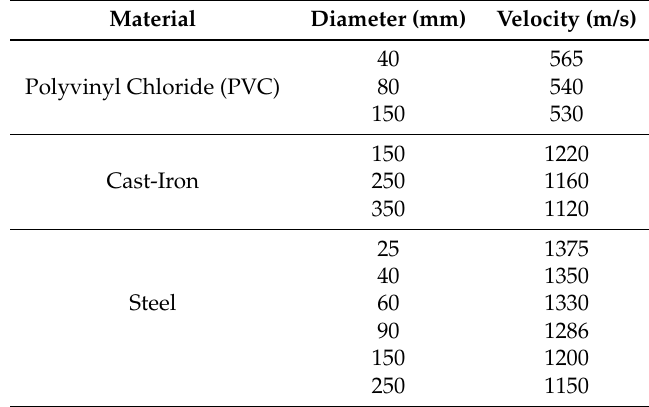
Table 1. Sound velocity according to the pipe material and diameter